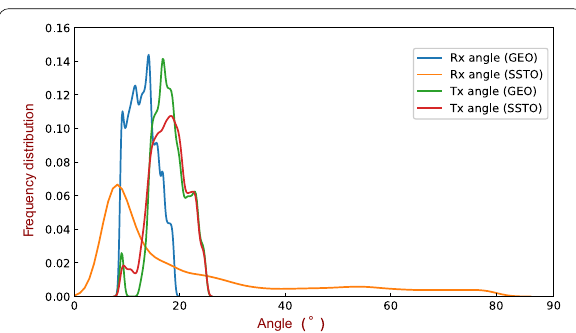
Fig. 10 Distribution of transmission angle and reception angle of all available signals (Physically visible and C/N 0 > 20 dB represents the value of Rx and Tx angle, the resolution is 1°, and the y axis corresponds to the proportion of the Rx and Tx angle in the